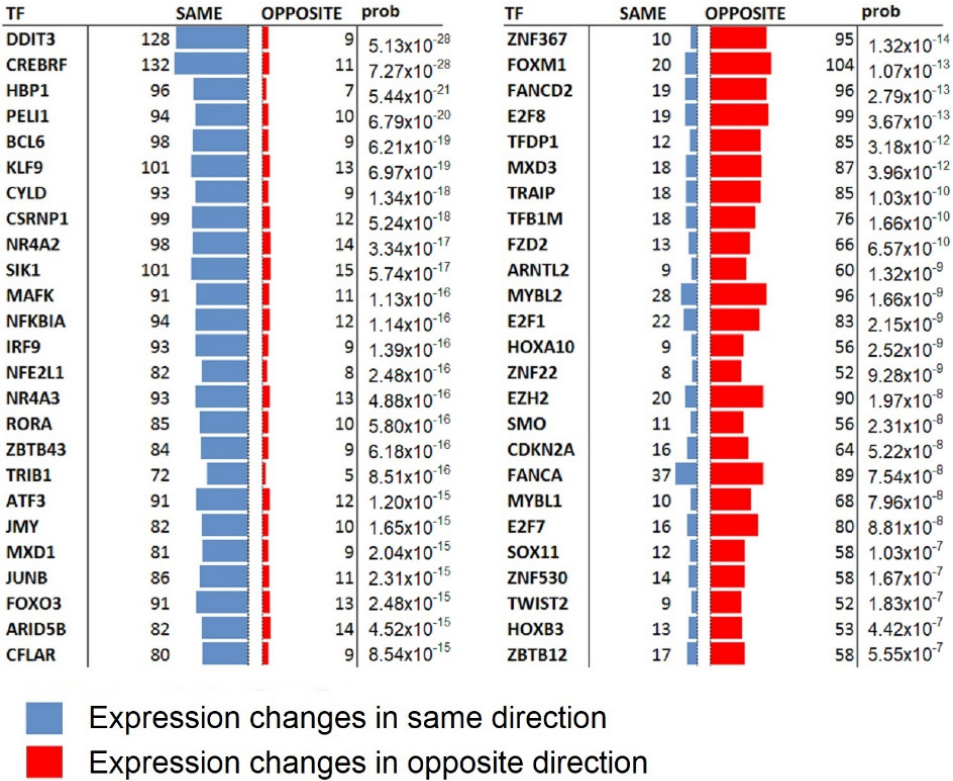
Figure 5. Transcription factors predicted to recapitulate the inhibitory activity of AM630. The AM630 transcription profile in the core cells restricted to 343 up and 348 down regulated genes passing the five standard deviations away from the null significance level, were queried against TFCEPs (see Methods). The positively correlating TFs are shown on the left and negatively correlating TFs on the right. Up/down regulation of the positively/negatively correlating TFs are hypothesised to recapitulate the inhibitory activity of